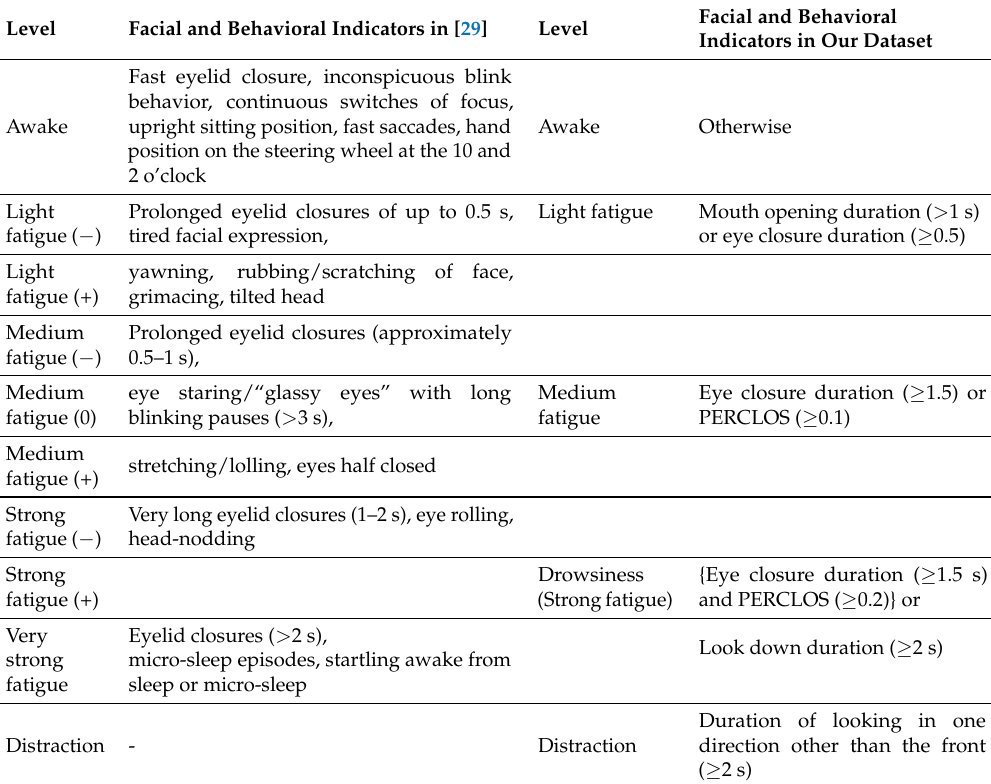
Table 2. Definitions of the driver